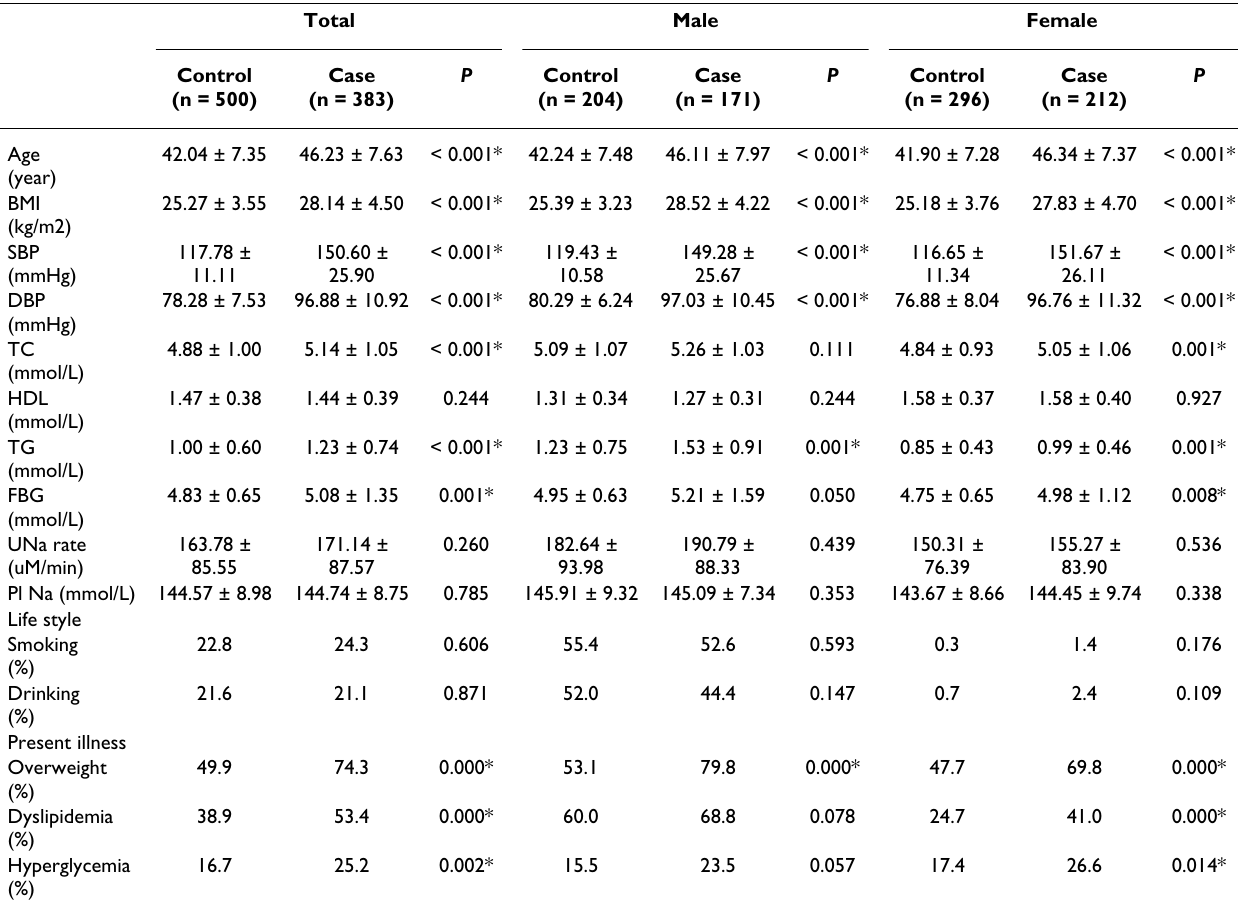
Table 2: Basic characteristics of subjects in hypertensives and normotensives